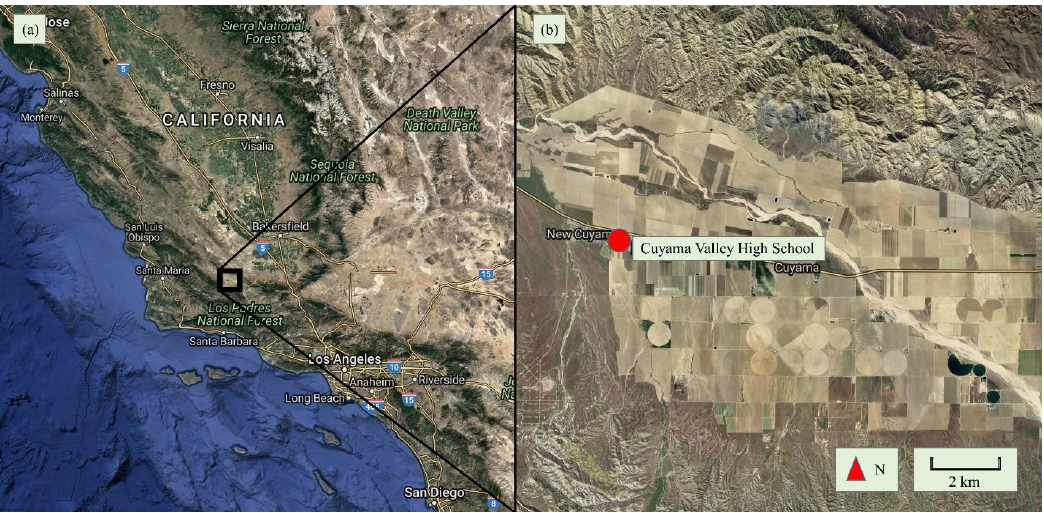
Figure 1. The location of Cuyama Valley in California ( a ), and the location of the field site within Cuyama Valley ( b ).